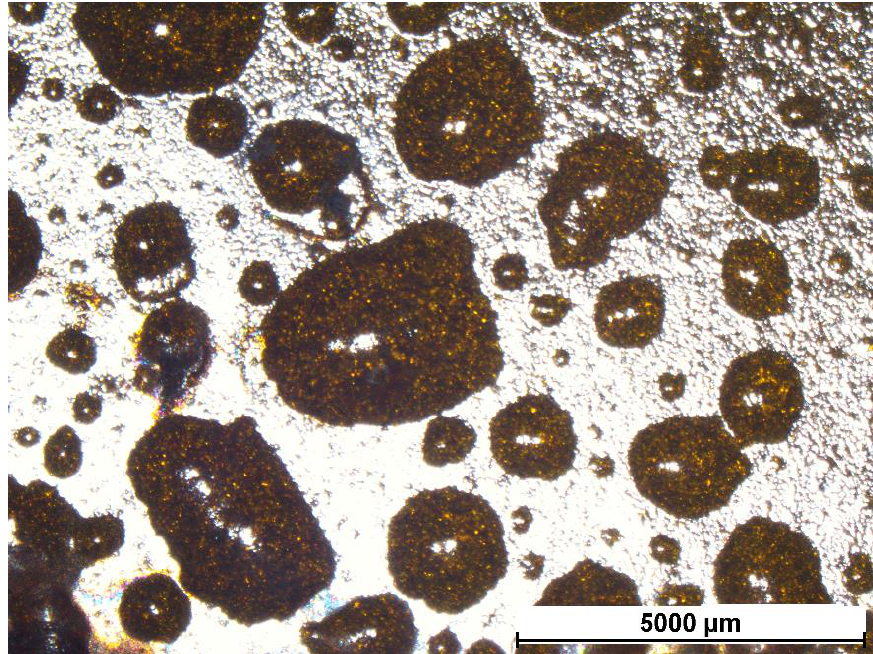
Figure 8. Detail of the blisters in sample A2 observed with the optical stereomicroscope at the end of the test.